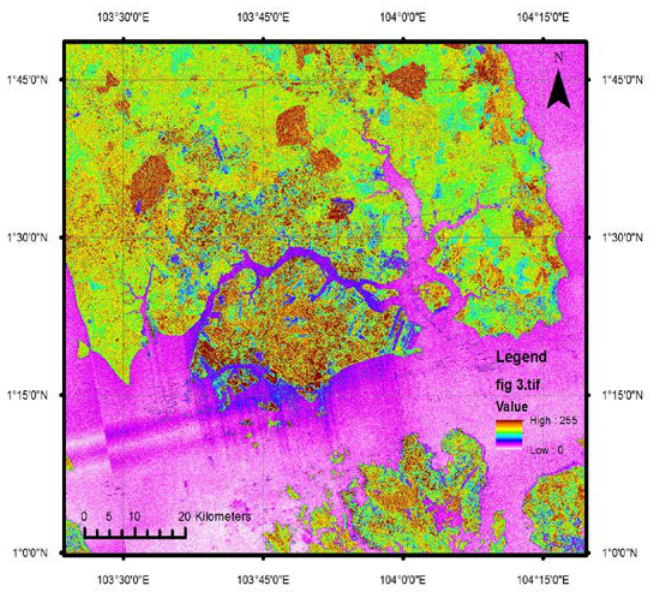
Figure 3. Image map of Johor Bahru estuary extracted from PALSAR HV polarization channel.